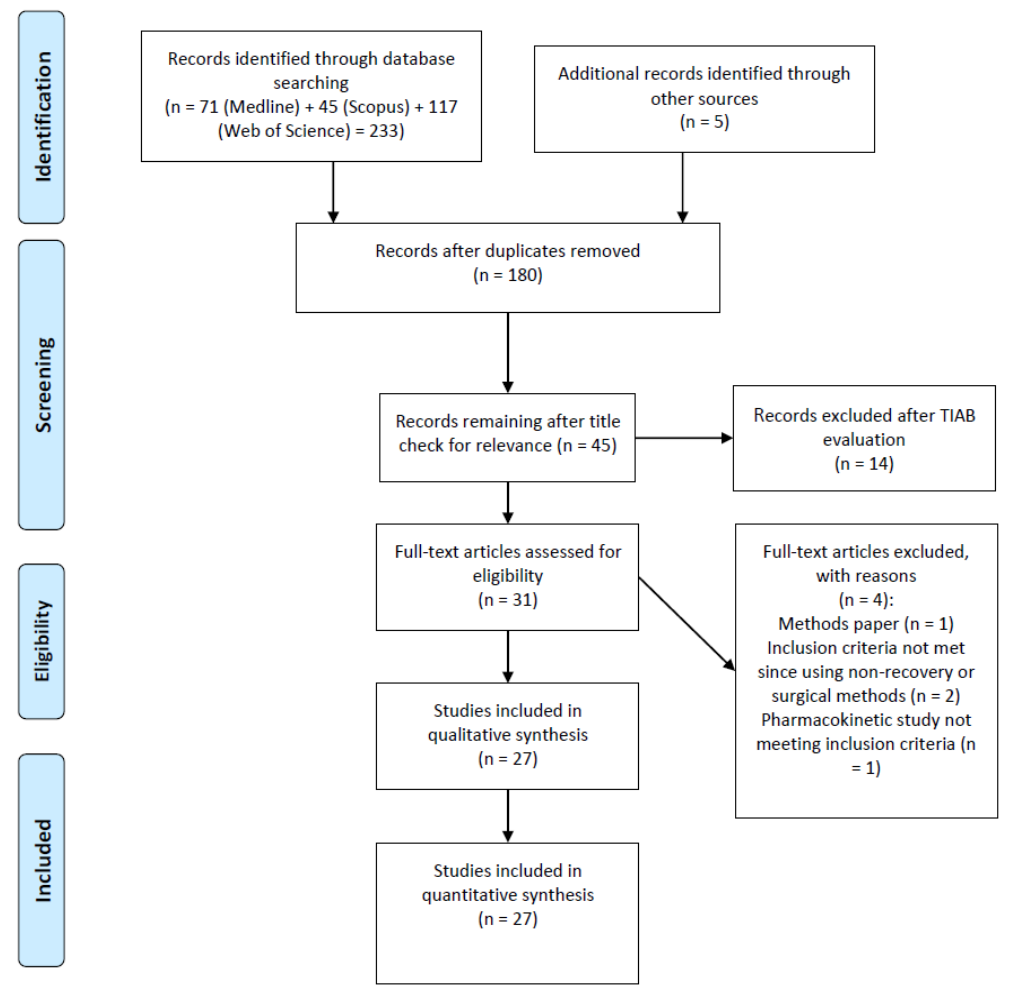
Figure 1. The PRISMA flow diagram for the systematic review detailing the database searches, the number of abstracts screened and the full texts retrieved.